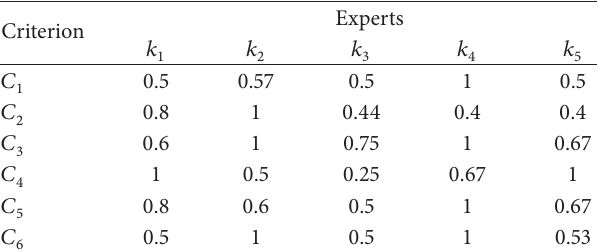
Table 7: The performance rating of the potential